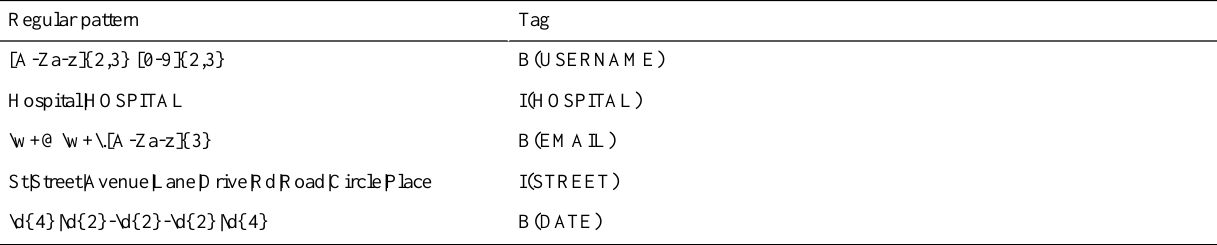
Table 1. Part of the patterns used in the initial-state